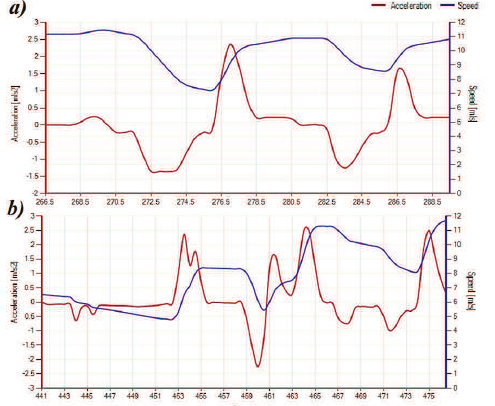
Fig. 8. Speed-acceleration pattern for selected vehicles; a) free flow traffic conditions b)saturated traffic